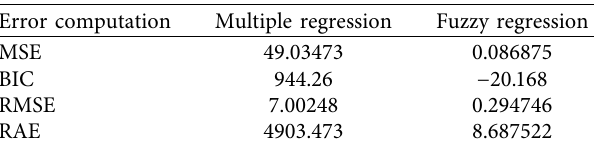
Figure 4: Fuzzy multiple regression using trapezoidal membership function. Table 6: Error comparison of multiple regression and fuzzy Table 7: Error comparison of multiple regression and fuzzy multiple regression. multiple regression.